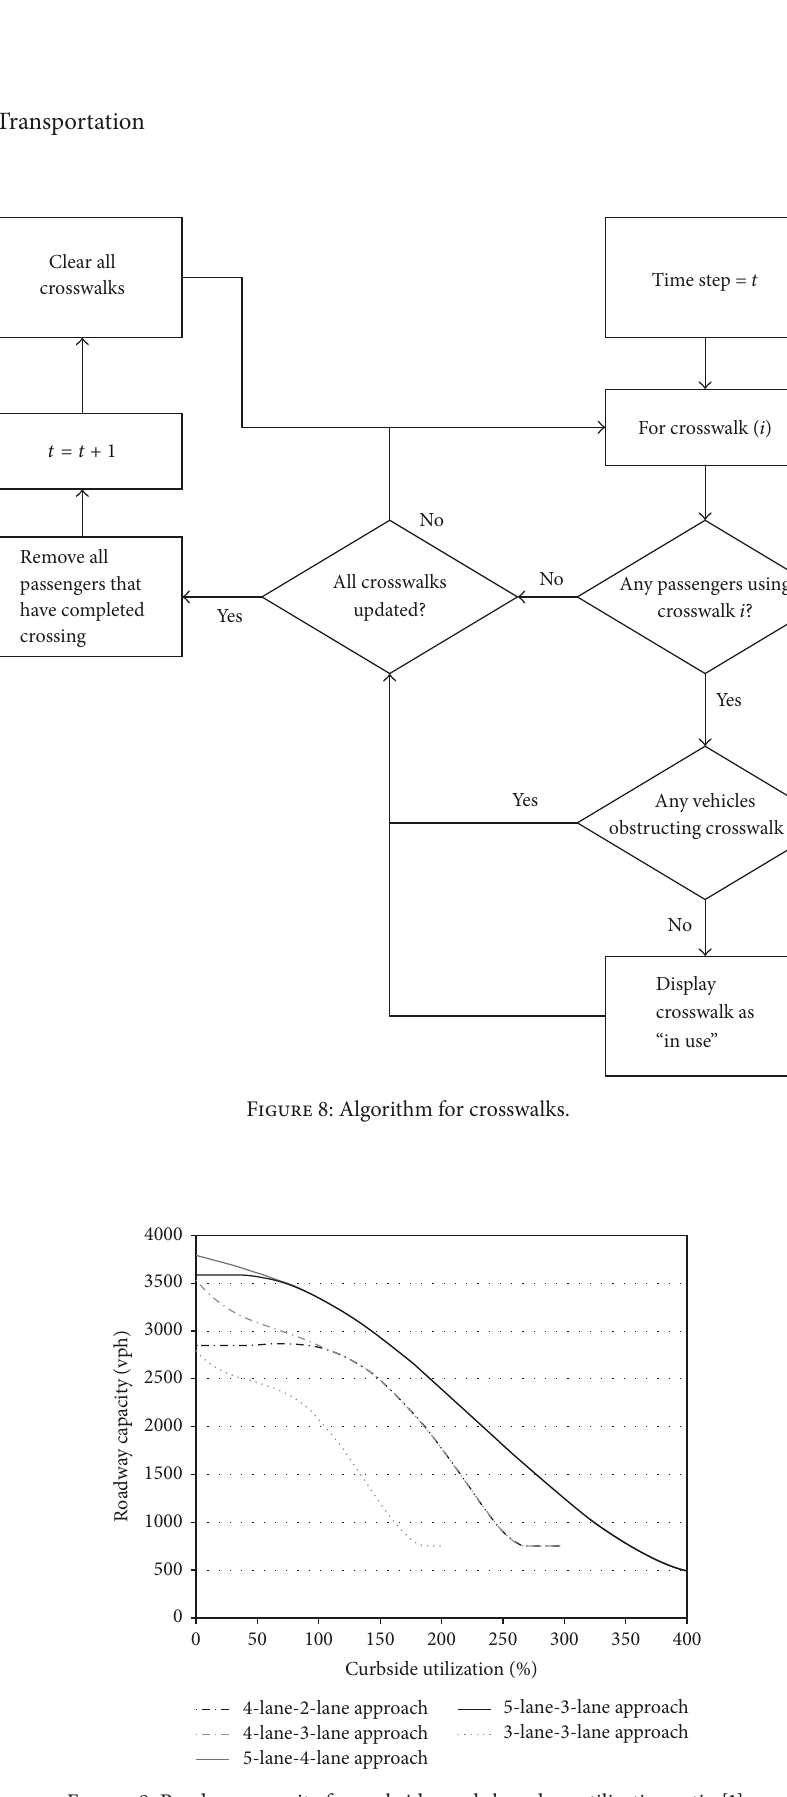
Figure 9: Roadway capacity for curbside roads based on utilization ratio